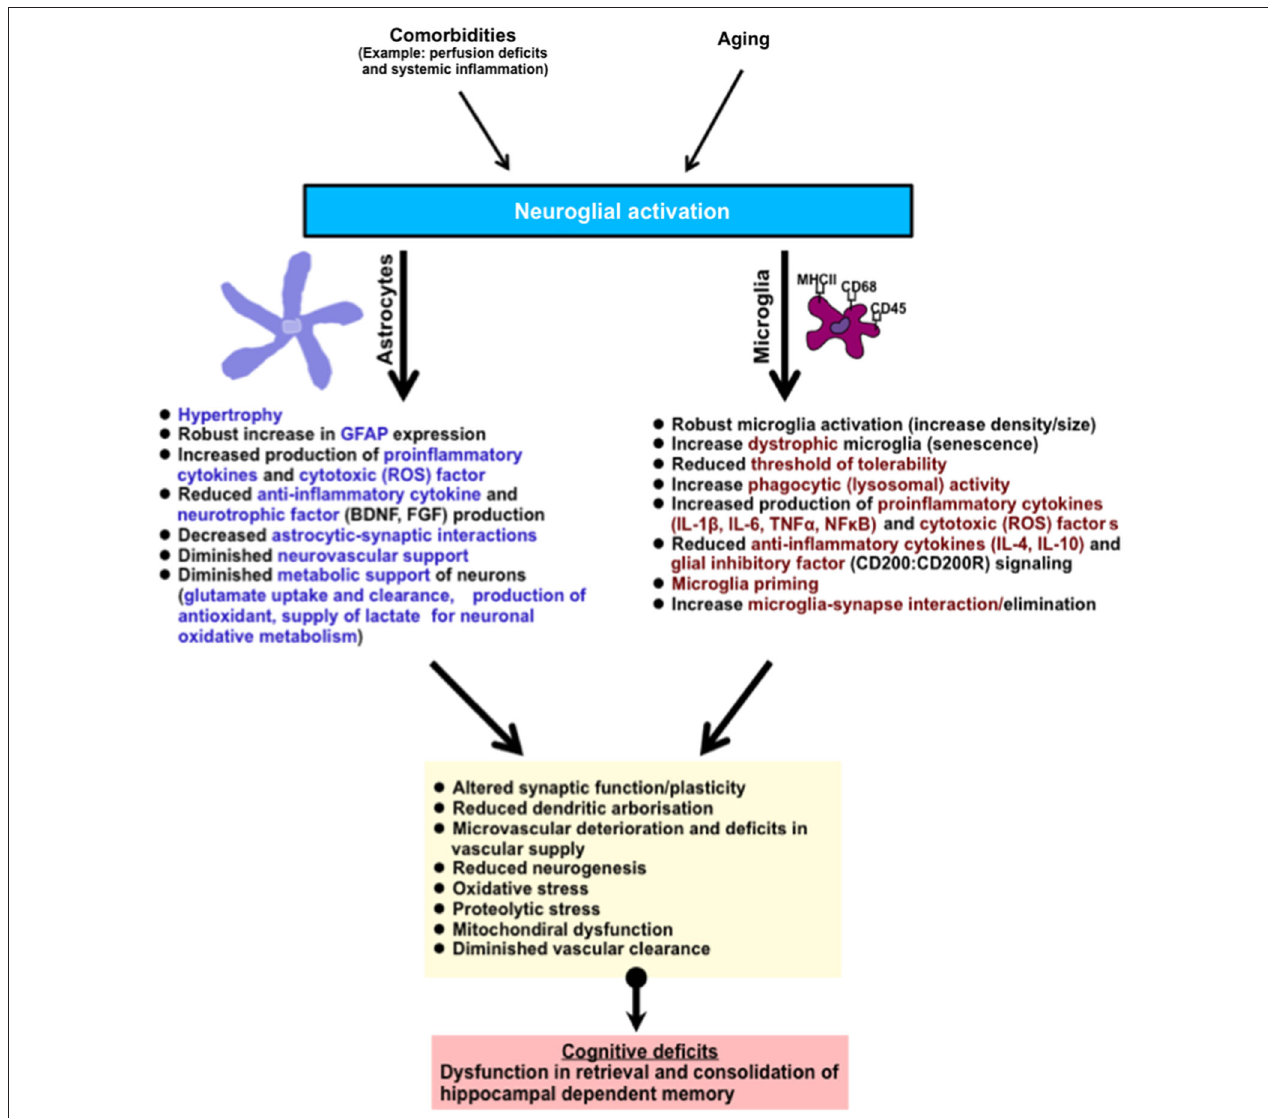
neurotrophic factors. In microglial cells, these changes are thought to contribute to their priming (and possible senescence), reducing their threshold of tolerability and therefore shifting the balance to increased age-related neuroinflammation and hence neurotoxicity. Astroglial cells, which are essential in metabolic support of neurons and vascular cells, progressively relinquish these supportive roles leading to deterioration in brain function. Together this culminates in subtle impairments in dendritic integrity, synaptic function, neurogenesis, increased oxidative metabolism, diminished protein clearance, and microvascular deterioration. Abbreviation: (ROS) reactive oxygen species such as nitric oxide,